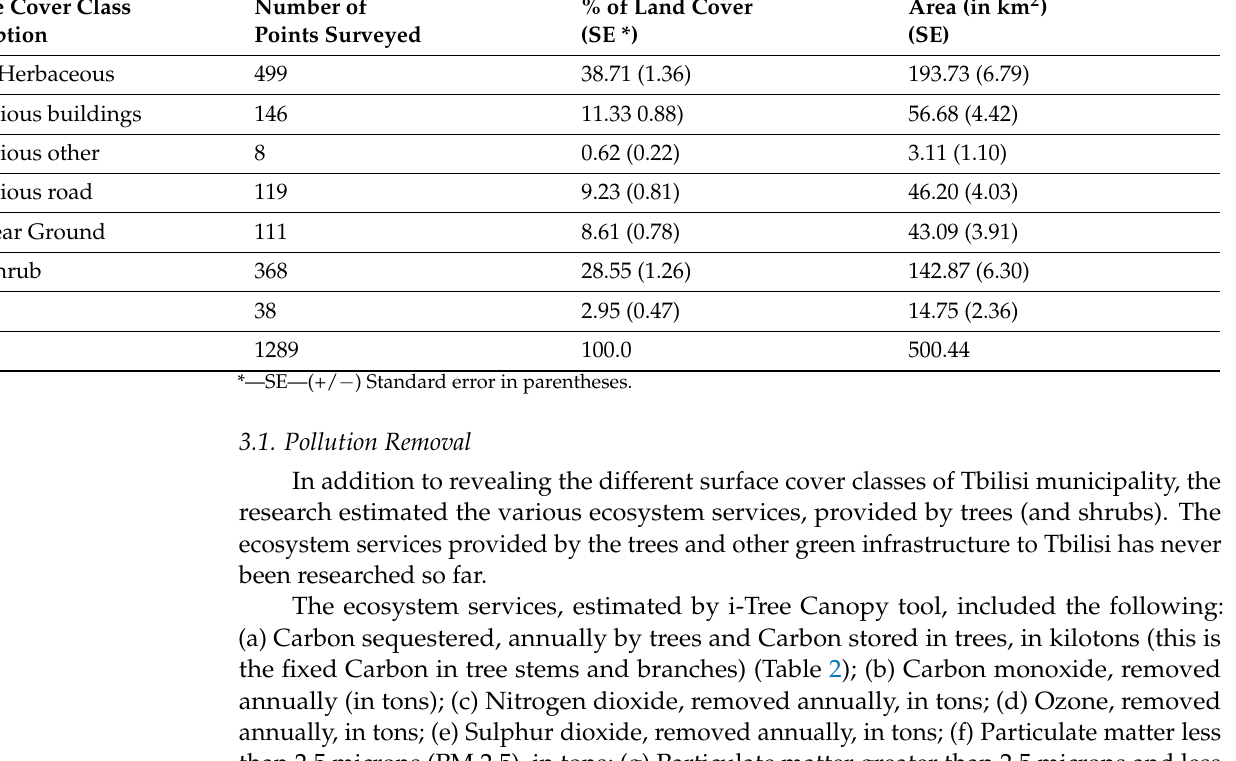
Table 1. Distribution of surface cover classes in Tbilisi, analyzed by i-Tree Canopy (v.7) software. Surface Cover Class